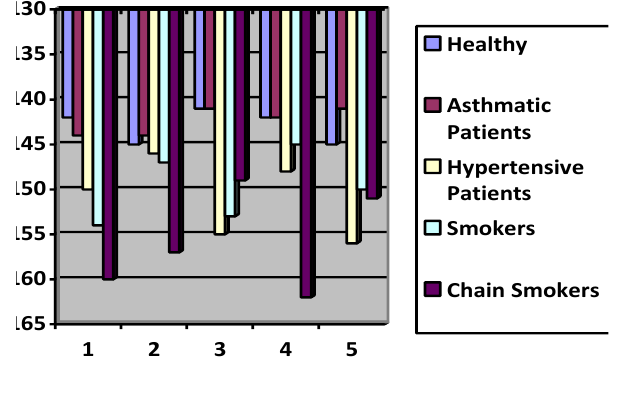
Fig. 9. Comparison bar chart for